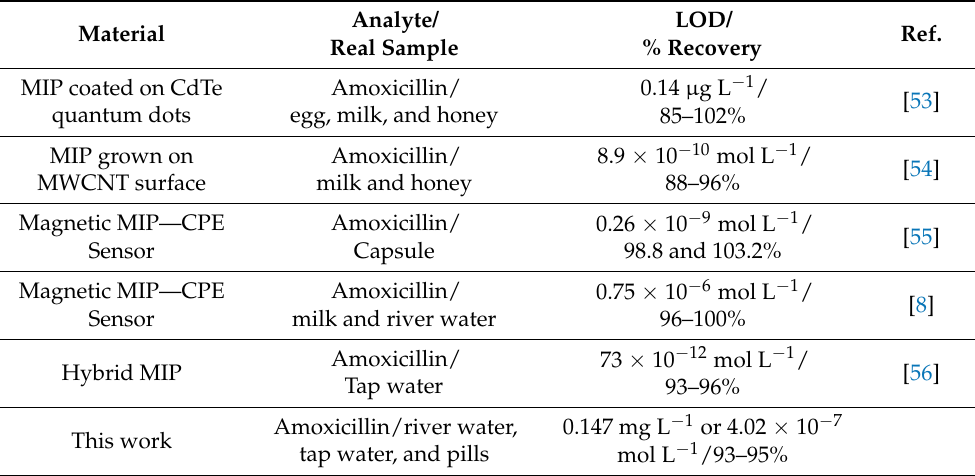
Table 7. Comparative study of the fabricated material with the literature for Amoxicillin